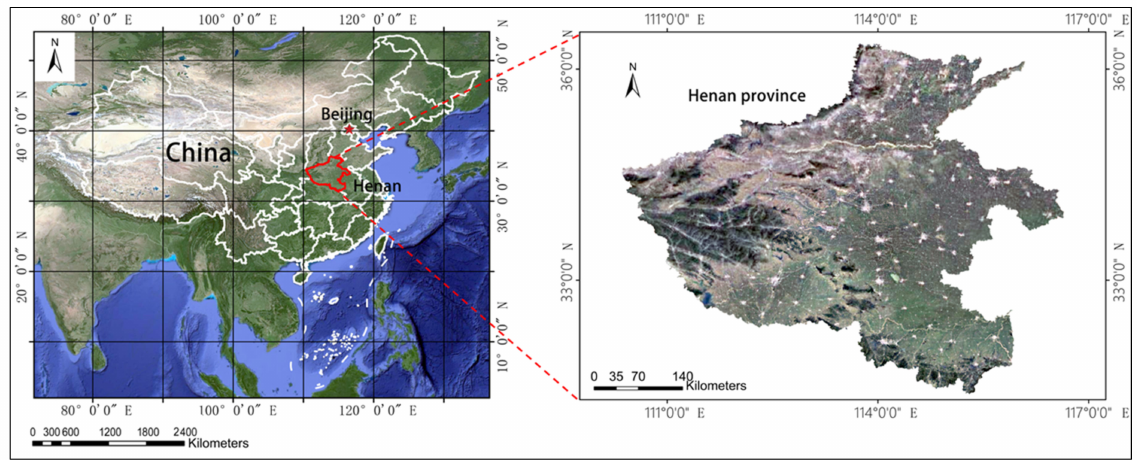
Figure 1. Remote sensing images of the study area in Henan Province.